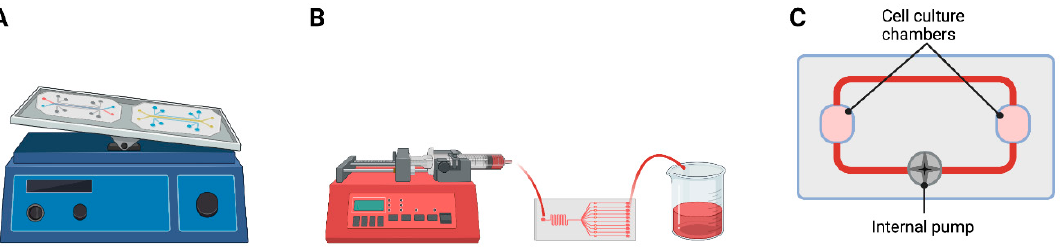
Figure 5. Methods and equipment to generate shear stress . Tilt movement in the rocker ( A ), external syringe pump ( B ), and internal pump within the chip ( C ). Created with BioRender.com.